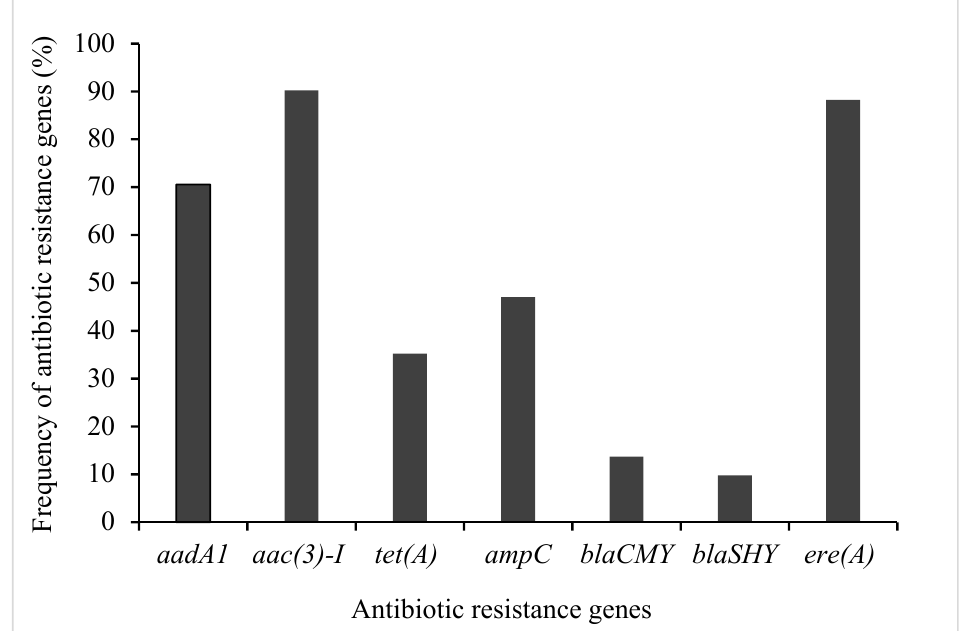
Figure 2. Antibiotic resistance gene profiles of STEC isolates.